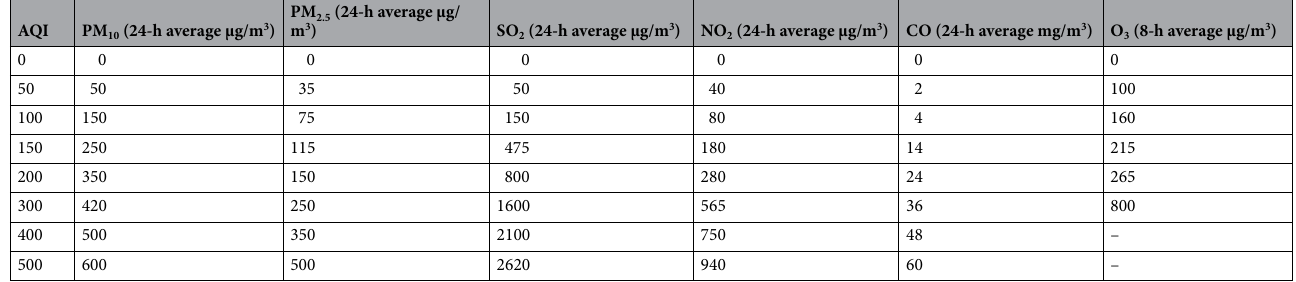
Table 1. Pollutant concentration